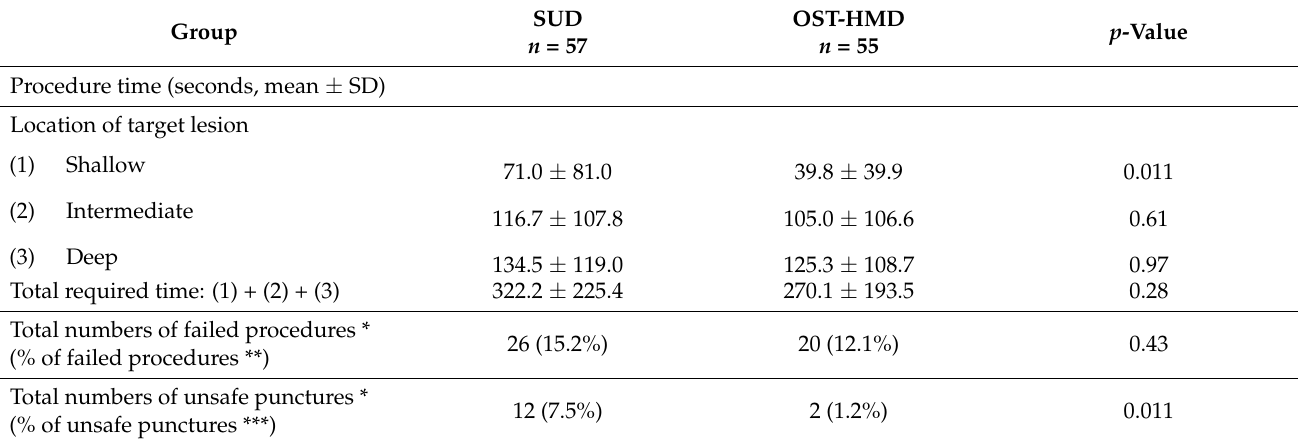
Table 2. Comparison of the procedure time, the number of failed procedures, and the frequency of unsafe punctures between the SUD and OST-HMD groups.